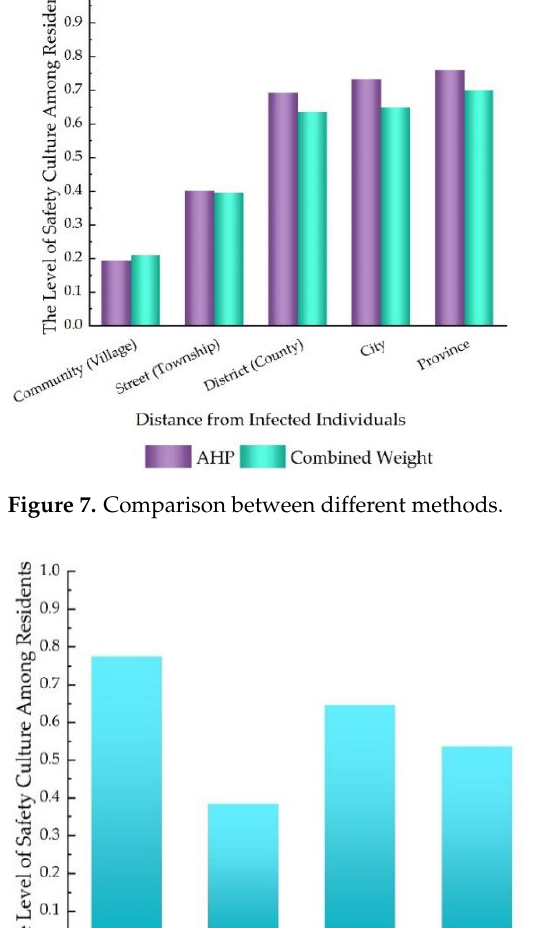
Figure 7. Comparison between different methods.